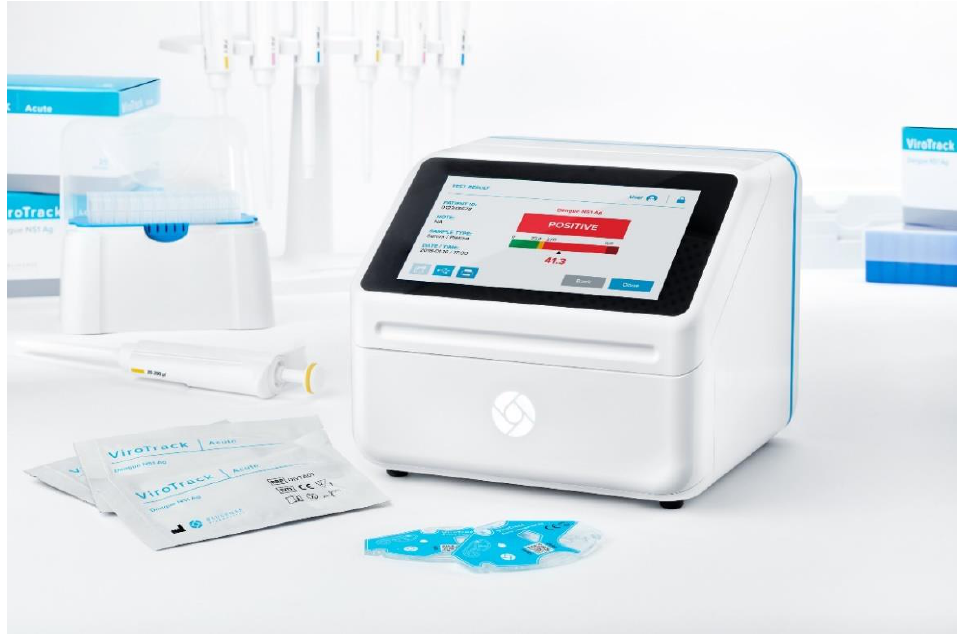
Figure 1. ViroTrack and BluBox.